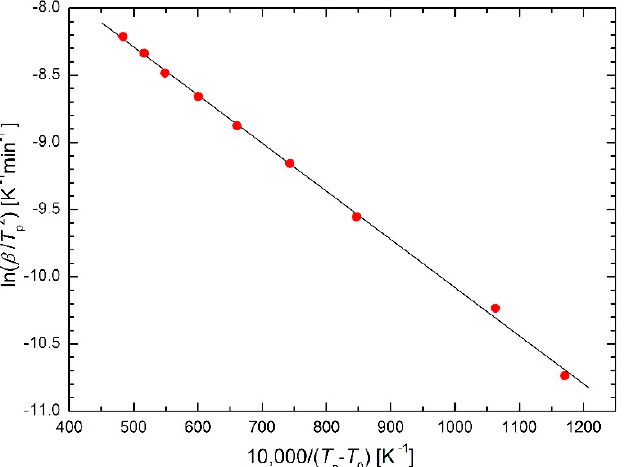
Figure 15. Kissinger plot for Ni-Mn-In-Mg shape memory alloy [5] using the modified Arrhenius Equation (23) as regression function. Replacing 1/ T axis by 1/( T − T 0 ), a linear plot is obtained instead of a curved